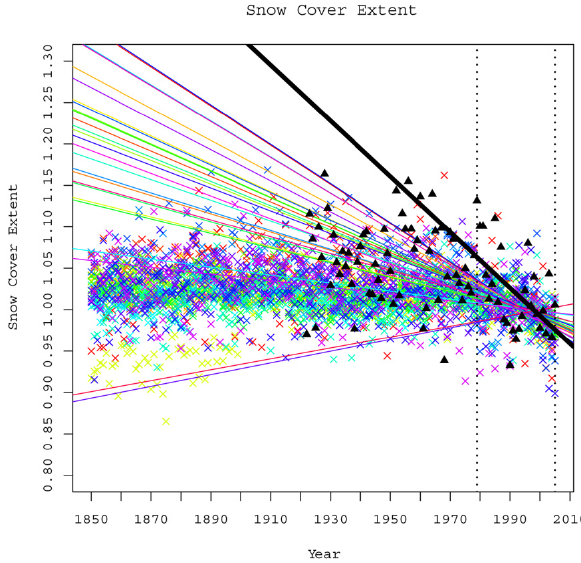
Fig. 4. March–April NH-ifl snow cover extent for the historical CMIP5 simulations of the individual models (colored crosses, nor- malized with respect to the simulated average 1986–2005 March– April extent) and observed March–April snow cover extent (black triangles, normalized with respect to the observed average 1986– 2005 March–April extent). Linear trends are calculated over the 1979–2005 period (black thick line: observed trend, colored lines: individual models). The vertical dotted lines indicate the 1979–2005 period over which the linear trend is